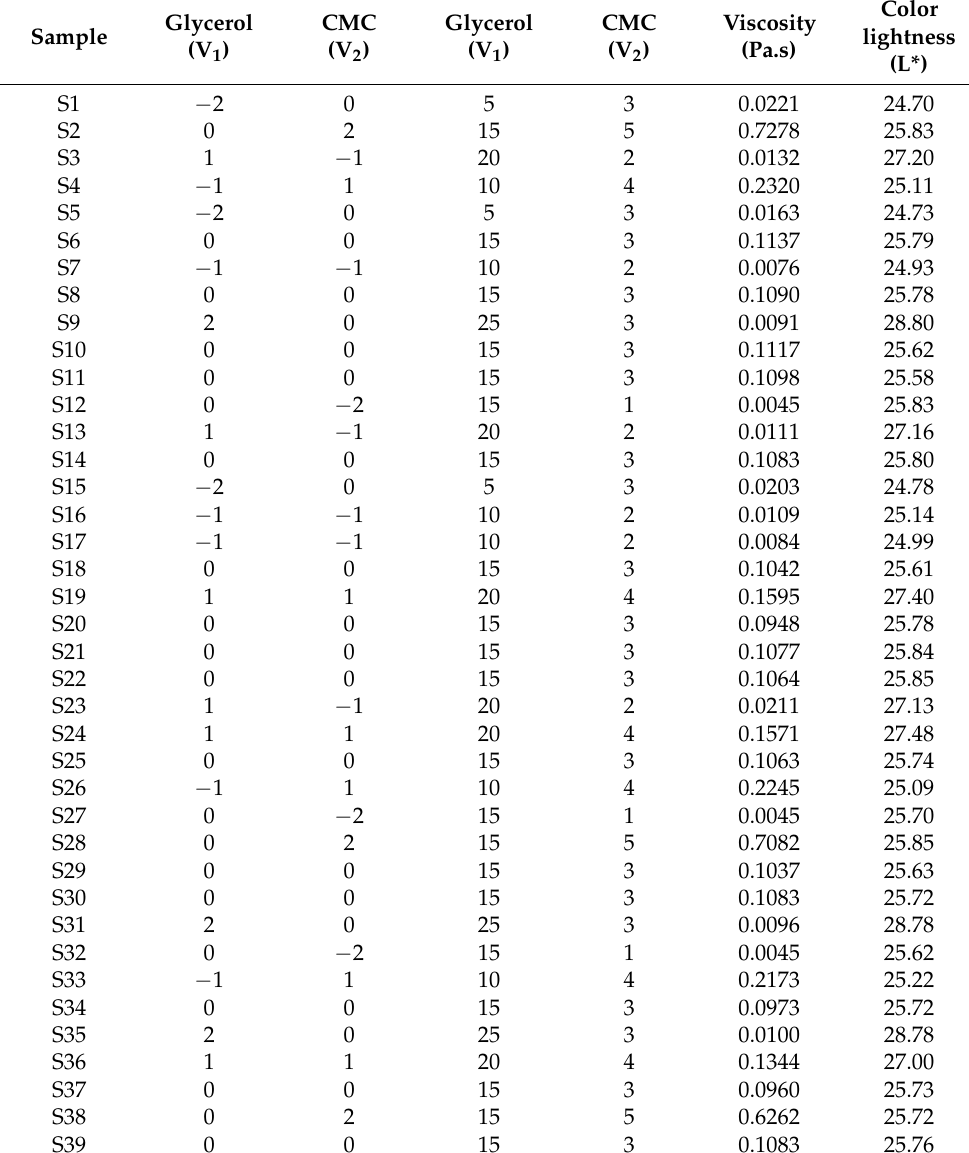
Table 4. Design matrix and response value for the viscosity and color lightness